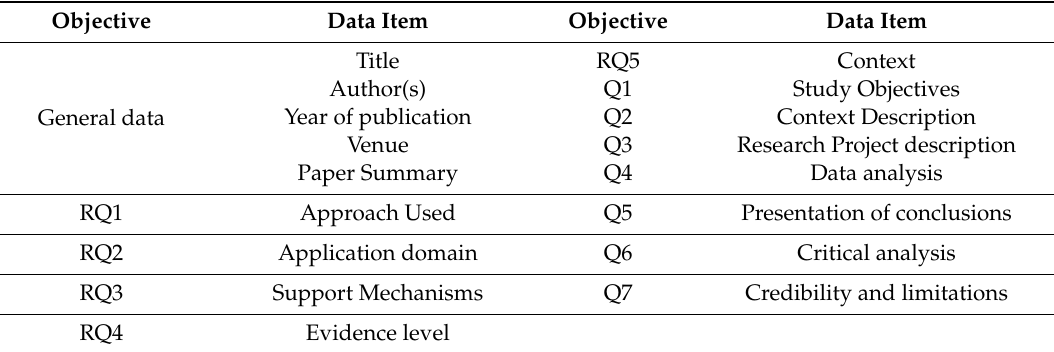
Table 4. Items extracted from each study, related research questions and quality